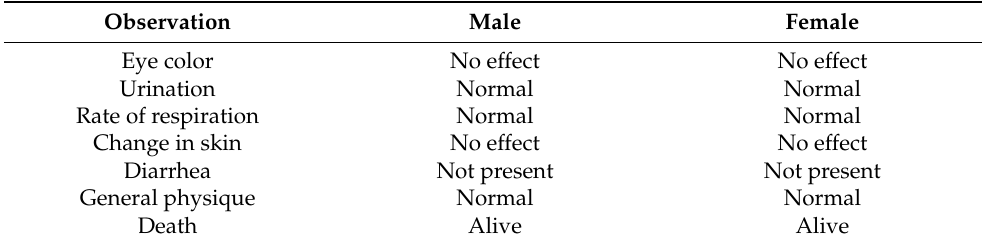
Table 6. General appearance and behavioral observations of the animal treated orally with emu oil in the acute